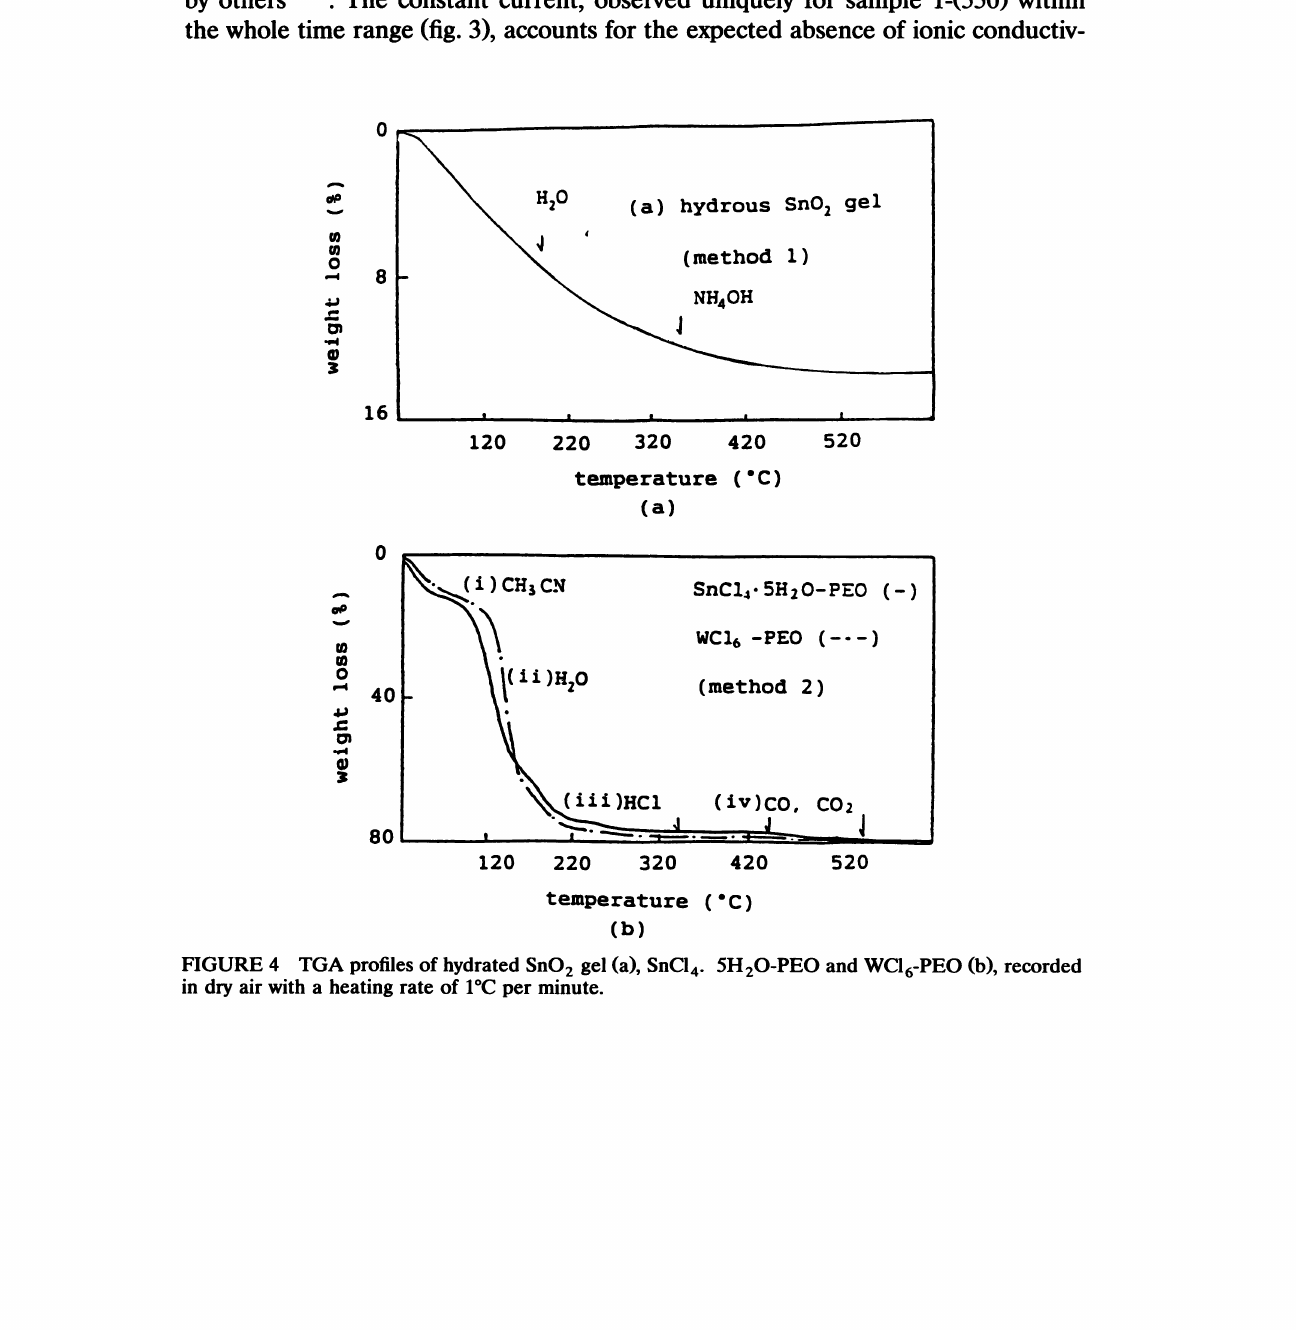
FIGURE 4 TGA profiles of hydrated SnO in dry air with a heating rate of IC per